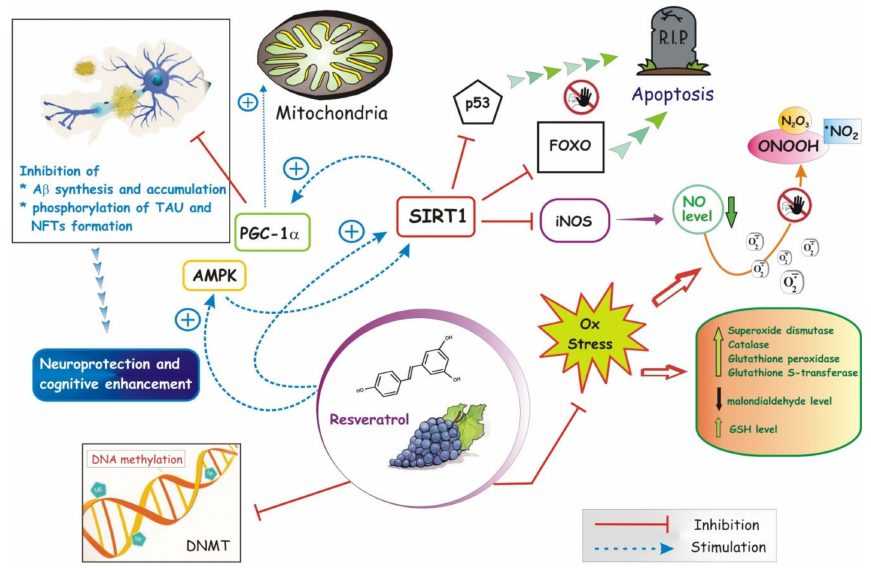
Figure 3. Resveratrol and Alzheimer’s disease. Alzheimer’s disease is a complex neurodegenerative disorder with multiple contributing factors. Some of the pathways a ff ected by Resveratrol are here